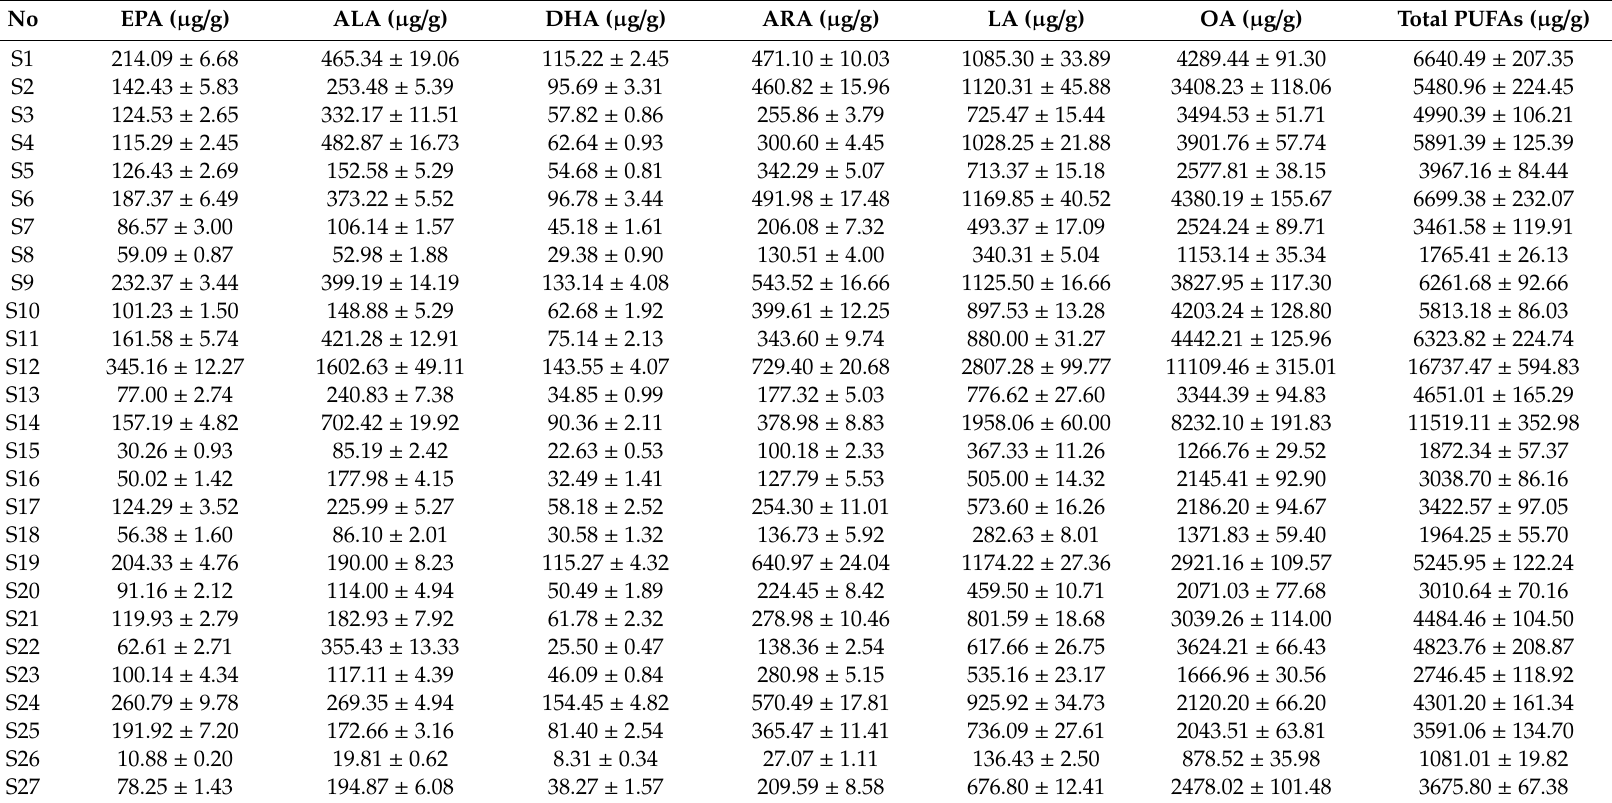
Table 4. The contents of PUFAs in 27 batches of Oviductus Ranae